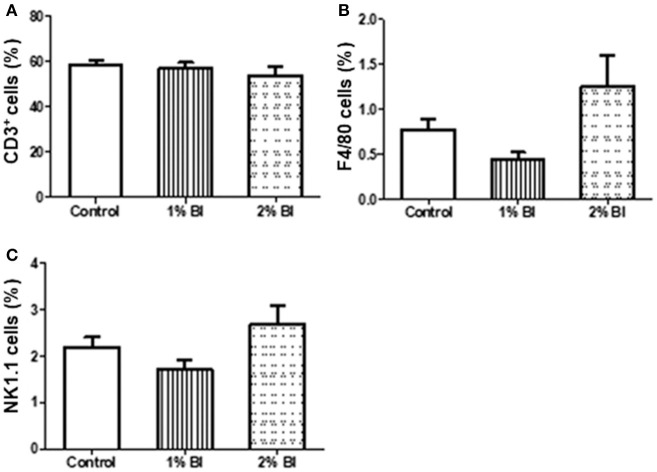
Effect of B. inquinans supplementation on mesenteric lymphocyte populations. On day 28, mice were sacrificed with CO2 and all mesenteric lymphocyte populations was collected and pooled to determine the immune cell populations including T cells [CD3, (A)], macrophages [F4/80, (B)] and NK cells [NK1.1, (C)] using flow cytometry described as the section Materials and Methods. Values are means ± SEM (n = 6 mice/group). Control, control diet; BI, B. inquinans.